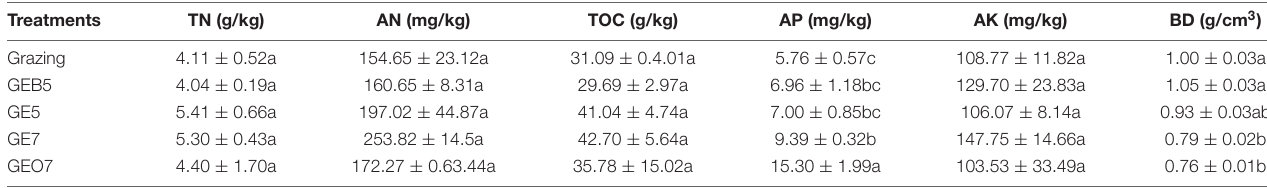
TABLE 4 | The change of soil properties among the grazing exclusion gradient. Treatments TN (g/kg) AN (mg/kg) TOC (g/kg) AP (mg/kg) AK (mg/kg) BD (g/cm 3 )